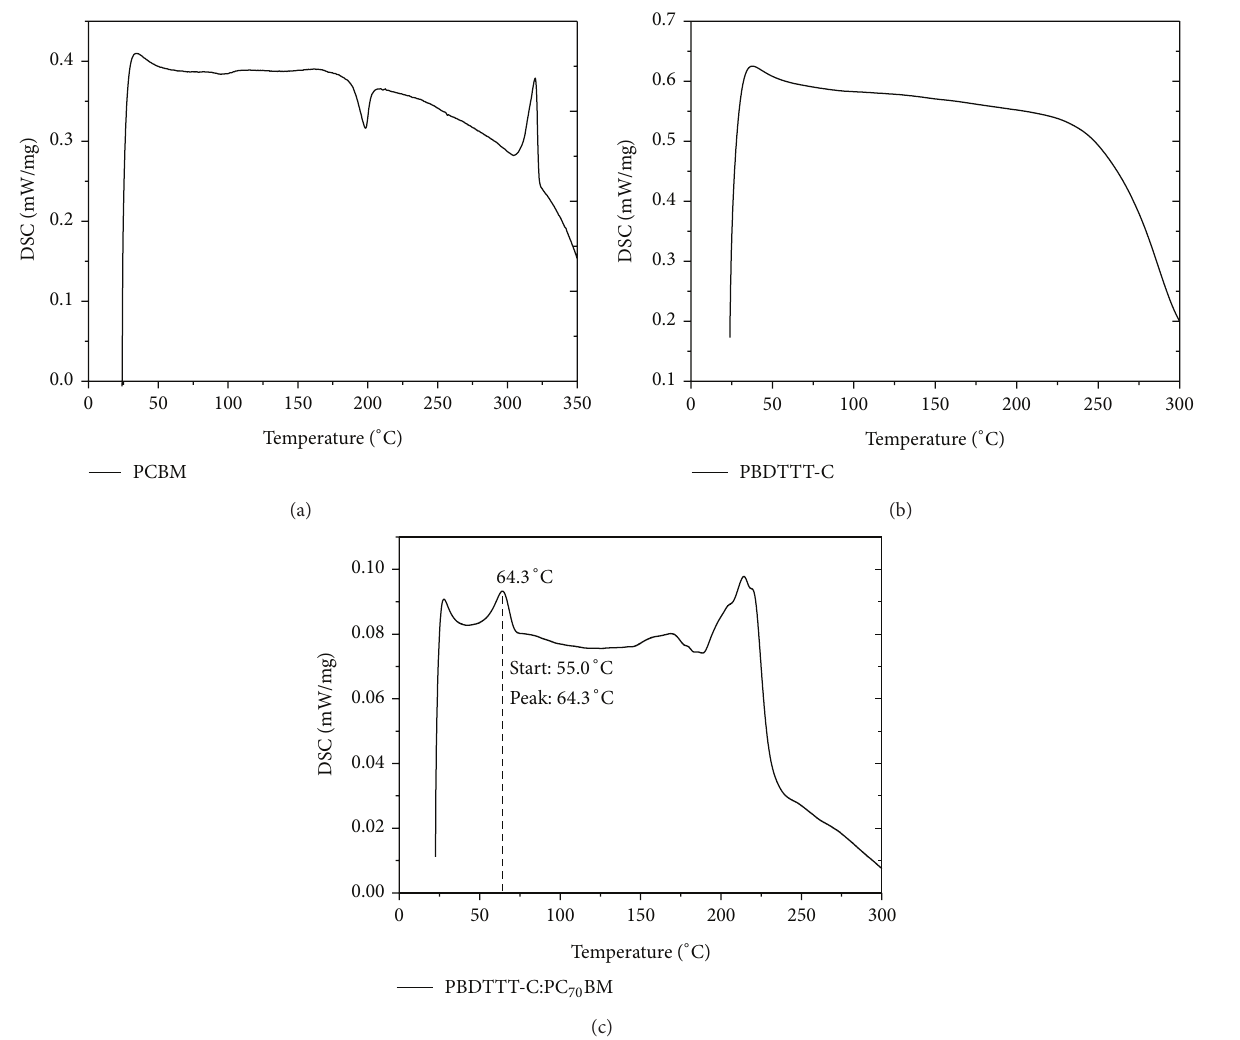
Figure 2: DSC thermograms showing the heating processes for the pure PC 70 BM (a), pure PBDTTT-C (b), and PBDTTT-C/PC 70 BM blends (c).